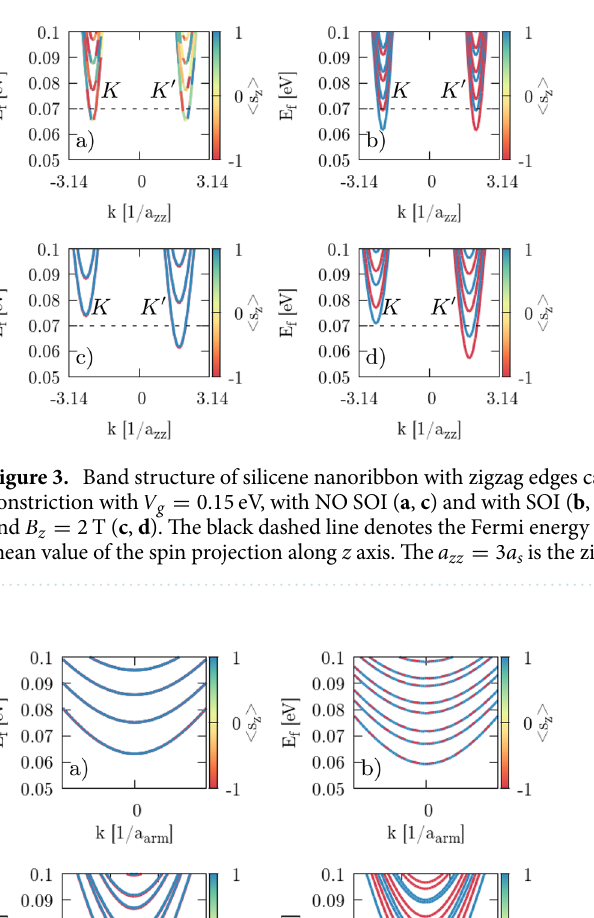
Figure 4. Same as Fig. 3 but for a nanoribbon with armchair edges. Armchair lattice period is equal to 6 a s a arm √ 3 =